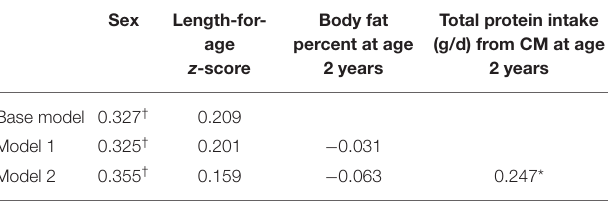
TABLE 3 | Standardised beta coefficients from multiple regression predictors of IGF-1 at 2 years of age in a subset of Auckland participants ( n = 79) participating in the GUMLi randomised controlled trial ( N =